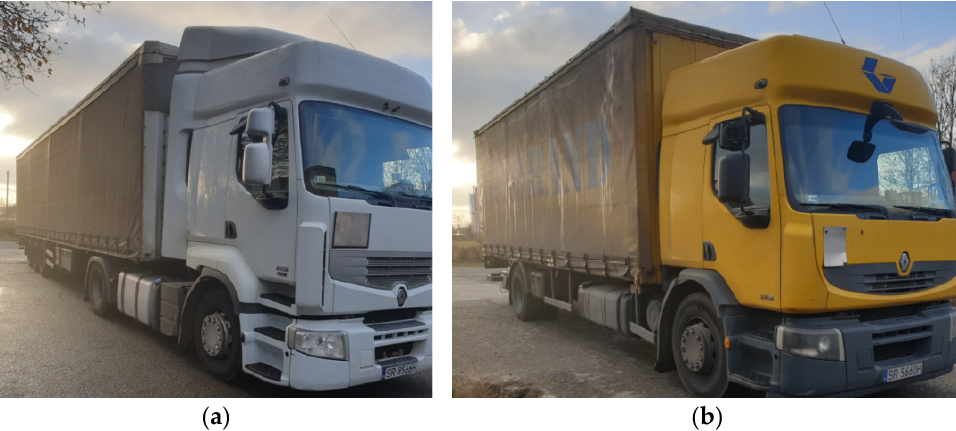
Figure 10. Vehicles used in the calibration exercise: ( a ) five-axle vehicle (category 5 acc. to COST 323), ( b ) two-axle vehicle (category 2 acc. to COST 323).